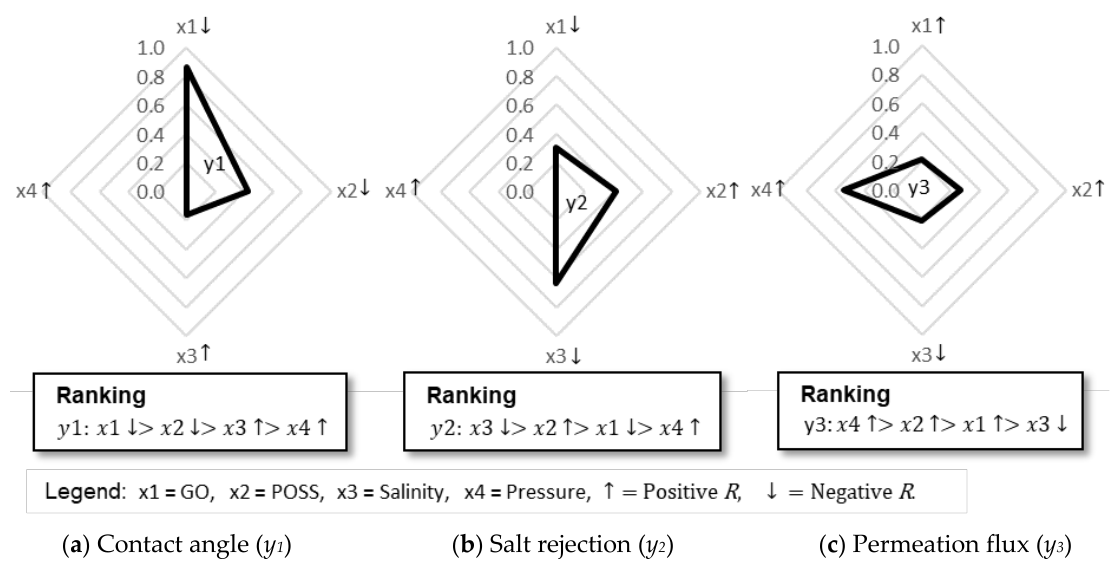
Table 4. Correlation R between the input and output components.